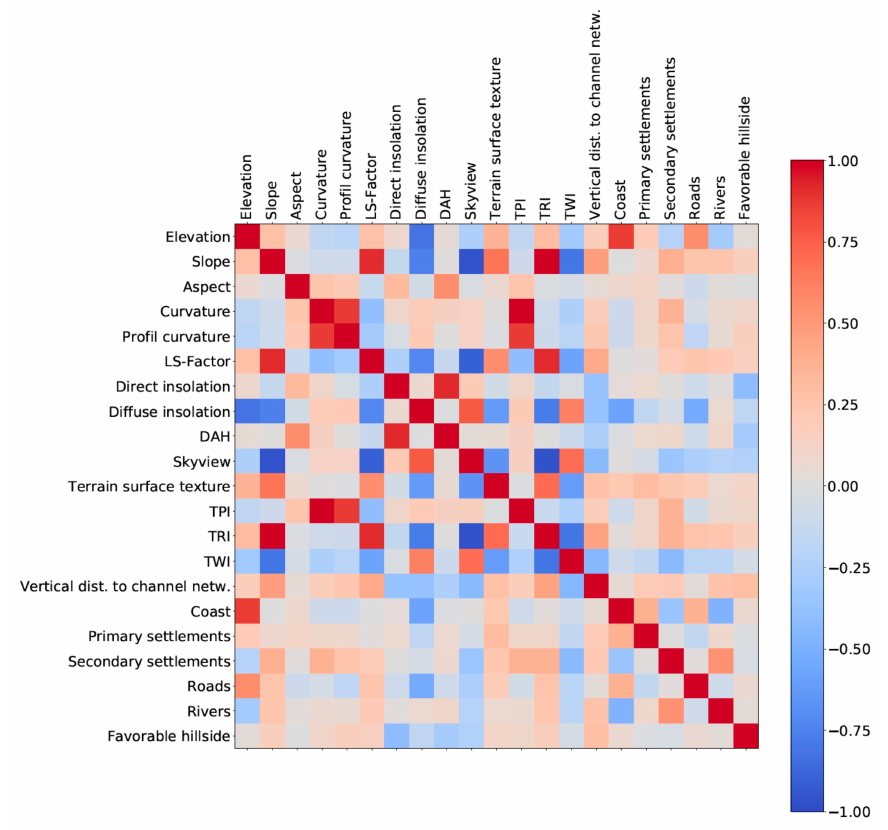
Figure 6. Correlation matrix of predictor variables showing Pearson’s correlation coe ffi